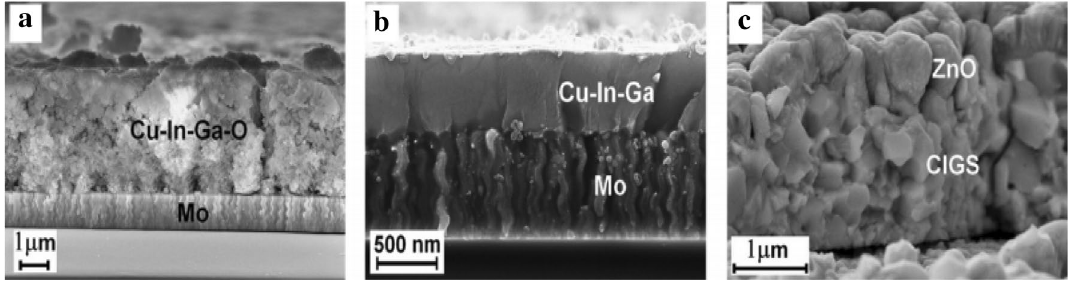
Fig. 5 SEM cross-sectional pictures of as-electrodeposited Cu–In–Ga mixed oxide precursor films ( a ), after reduction under Ar-5% H 2 into metallic alloy ( b ), and after selenization and front contact layers dep-